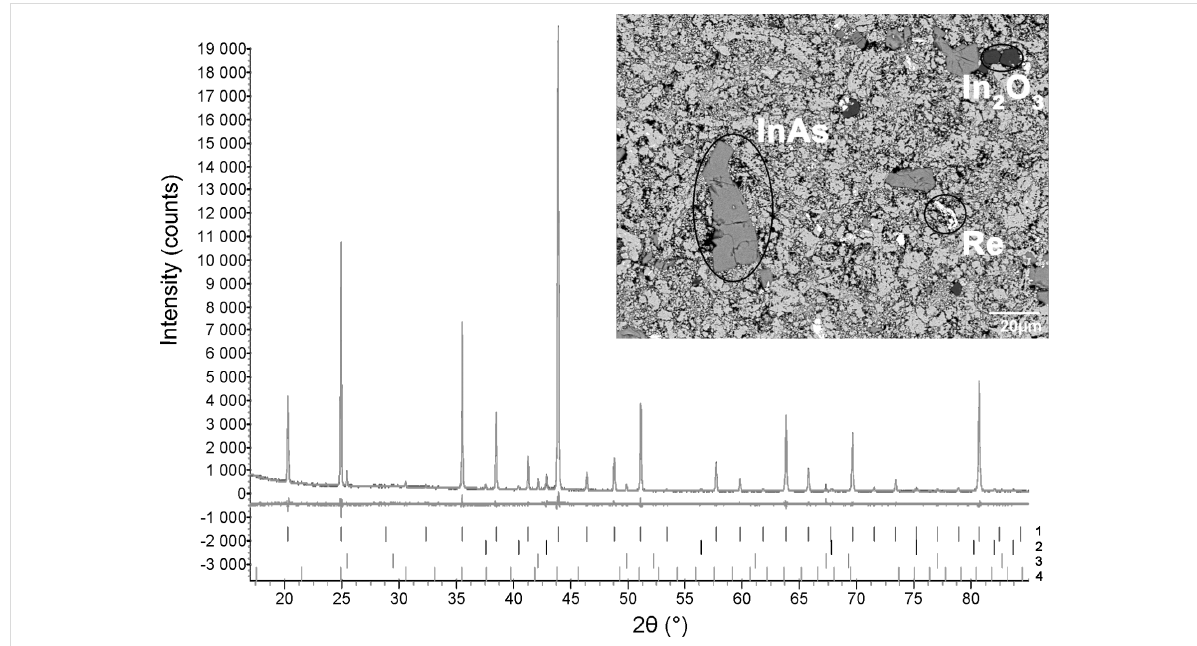
Figure 1: The plot of Rietveld refinement for the S1 sample. Experimental and difference curves, and positions of Bragg peaks are shown on the plot. Marked with numbers: 1: Re 3 As 6.70(3) In 0.30(3) ; 2: Re; 3: InAs; 4: In 2 O 3 . Inset: SEM micrograph of S1 showing the distribution of secondary phases in the microstructure (the most contaminated portion was chosen for showing all three admixtures).